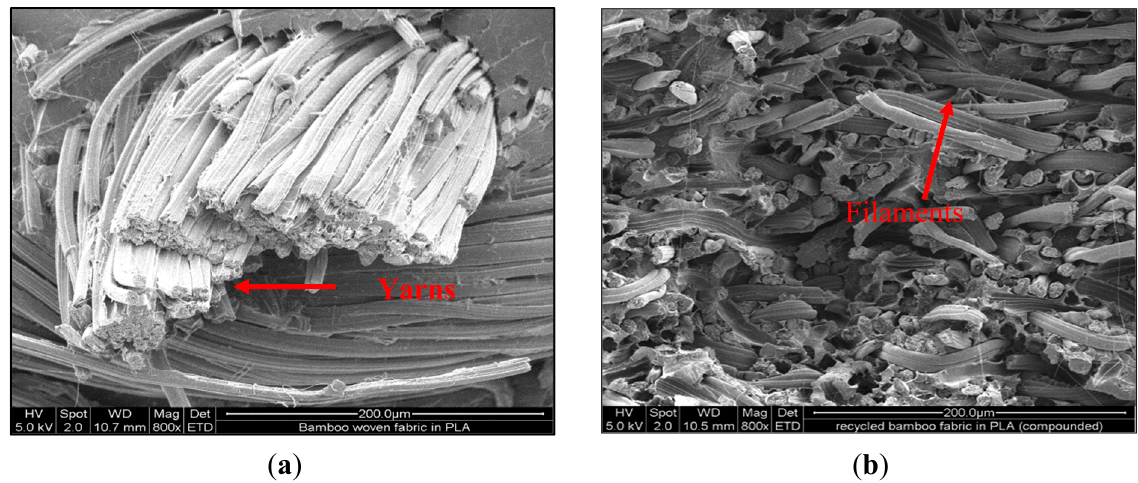
Figure 4. Environment scanning electron microscopy (ESEM) images of: ( a ) BF-PLA composite; and ( b ) recycled BF-PLA composite.